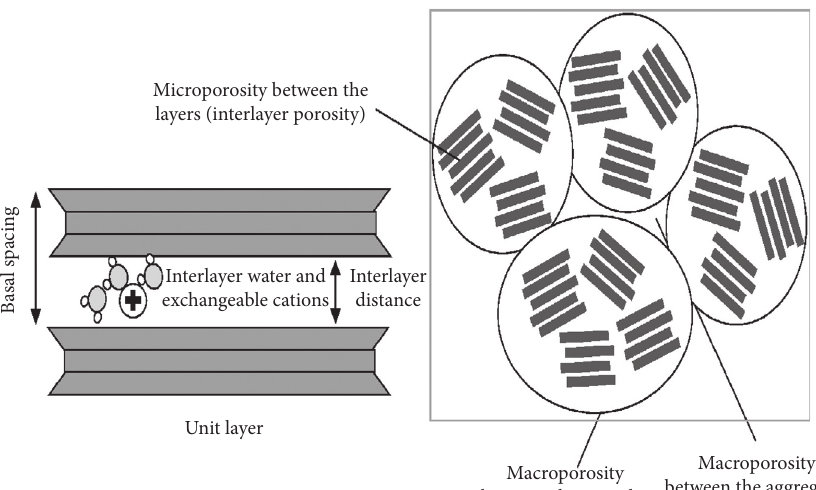
Figure 1: Effect of water entry on micro- and macroplates of compacted smectite with classification of “microporosity” and “macro- porosity,” reproduced with permission from